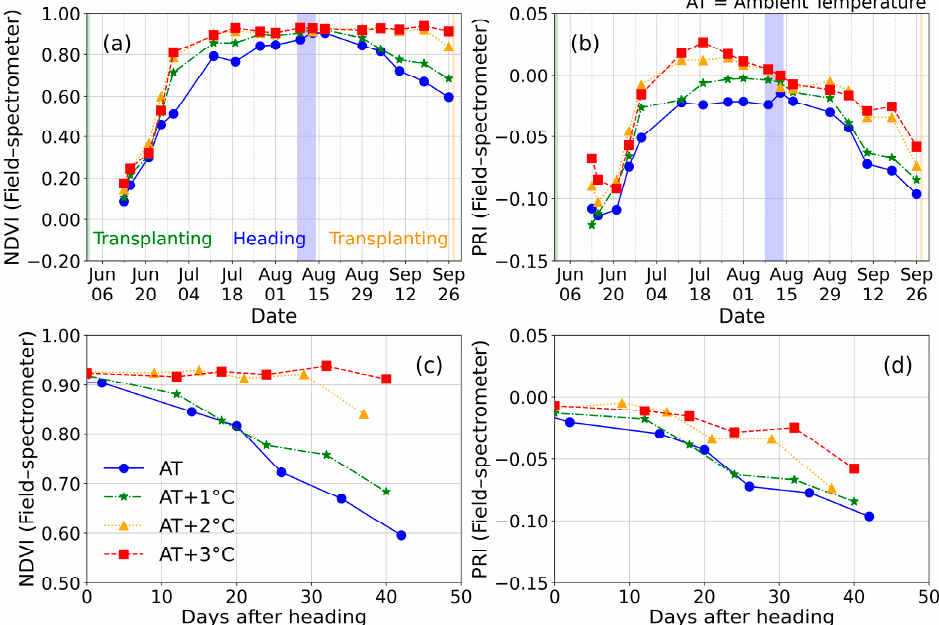
Figure 8. Time series of NDVI and PRI measured from field-spectrometers (canopy scale) depending on heat stress. Time series of ( a ) NDVI and ( b ) PRI during cultivation periods. Changes of ( c ) NDVI and ( d ) PRI based on the heading date.